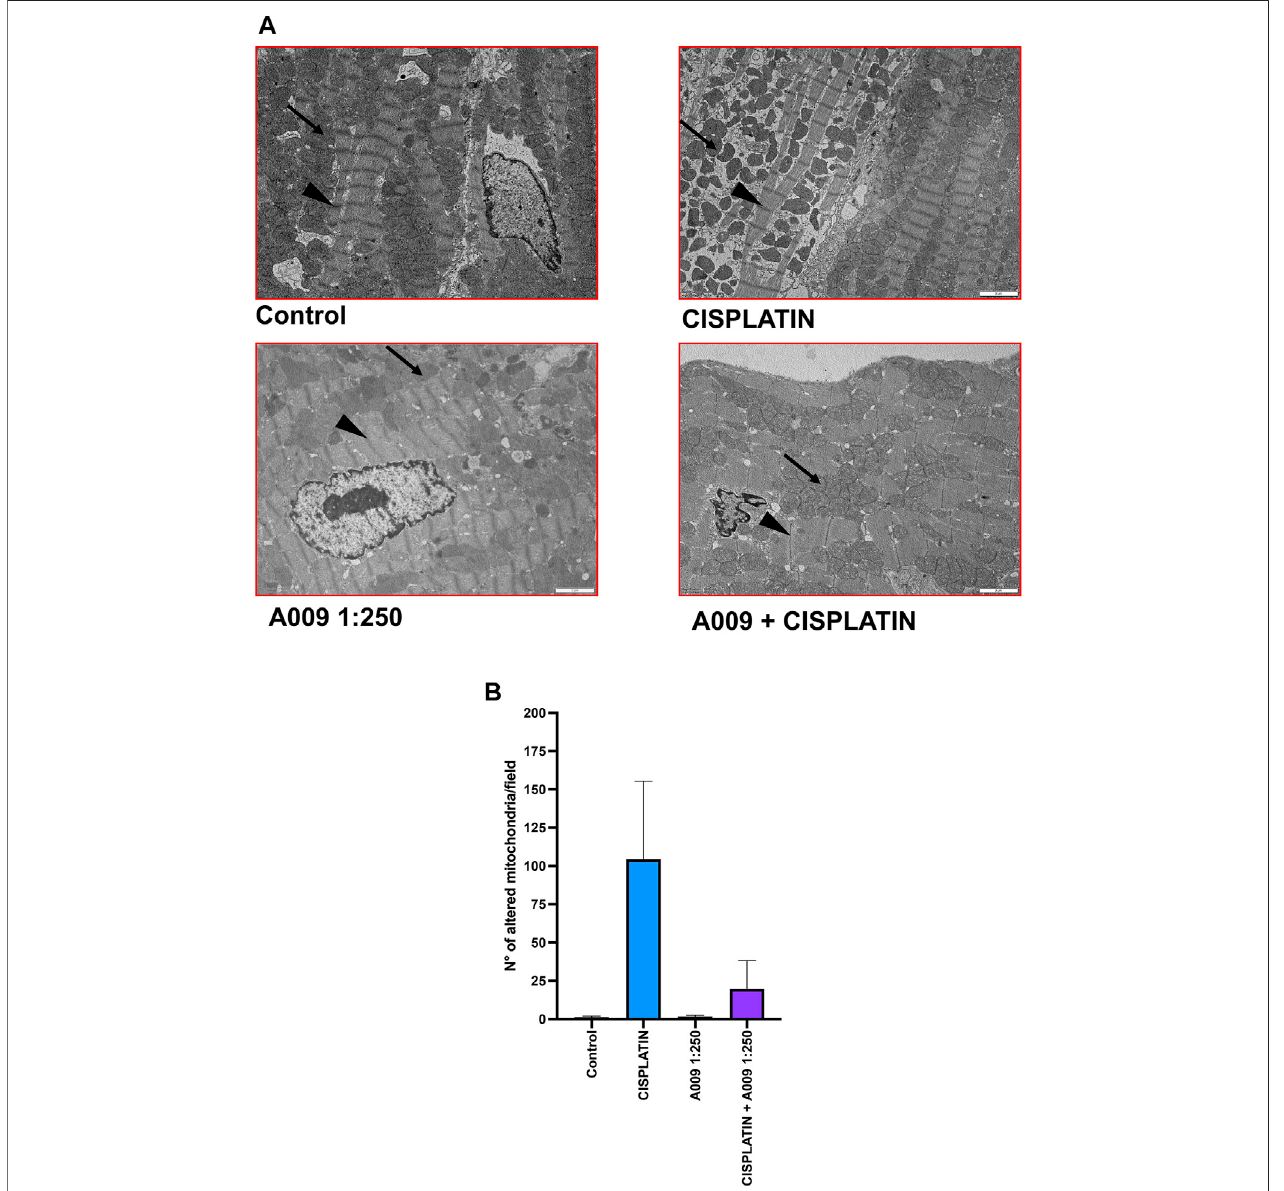
FIGURE 2 | A009 cardioprotective activities against cisplatin-induce cardiotoxicity in vivo . Mitochondria number, shape/morphology and color was monitored, by transmission electron microscopy (TEM) on hearts from mice treated with cisplatin alone (7 mg/kg), A009 extract (dilution 1:250, in drinking water) or the cisplatin-A009 extract combination. (A) representative TEM micrographs (arrows for the mitochondria, arrowheads for the z-line). (B) graph bars showing the count of altered mitochondria per experimental condition. Data are showed as mean ± SEM.